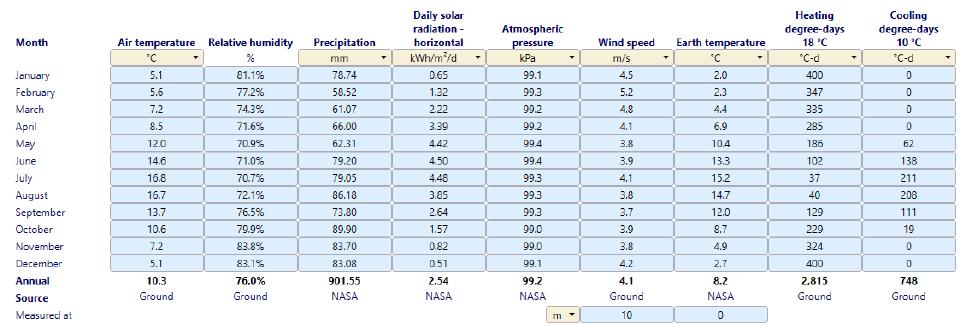
Figure 6. Meteorological data for London, United Kingdom.